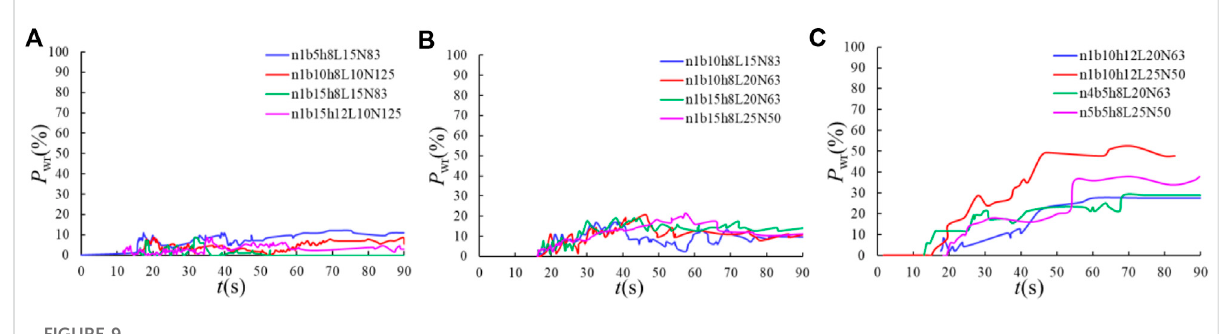
FIGURE 9 Different drainage patterns of LW at the slit-check dam. (A) Smoothly draining, (B) Intermittently blocking-breaking, and (C) Continuously